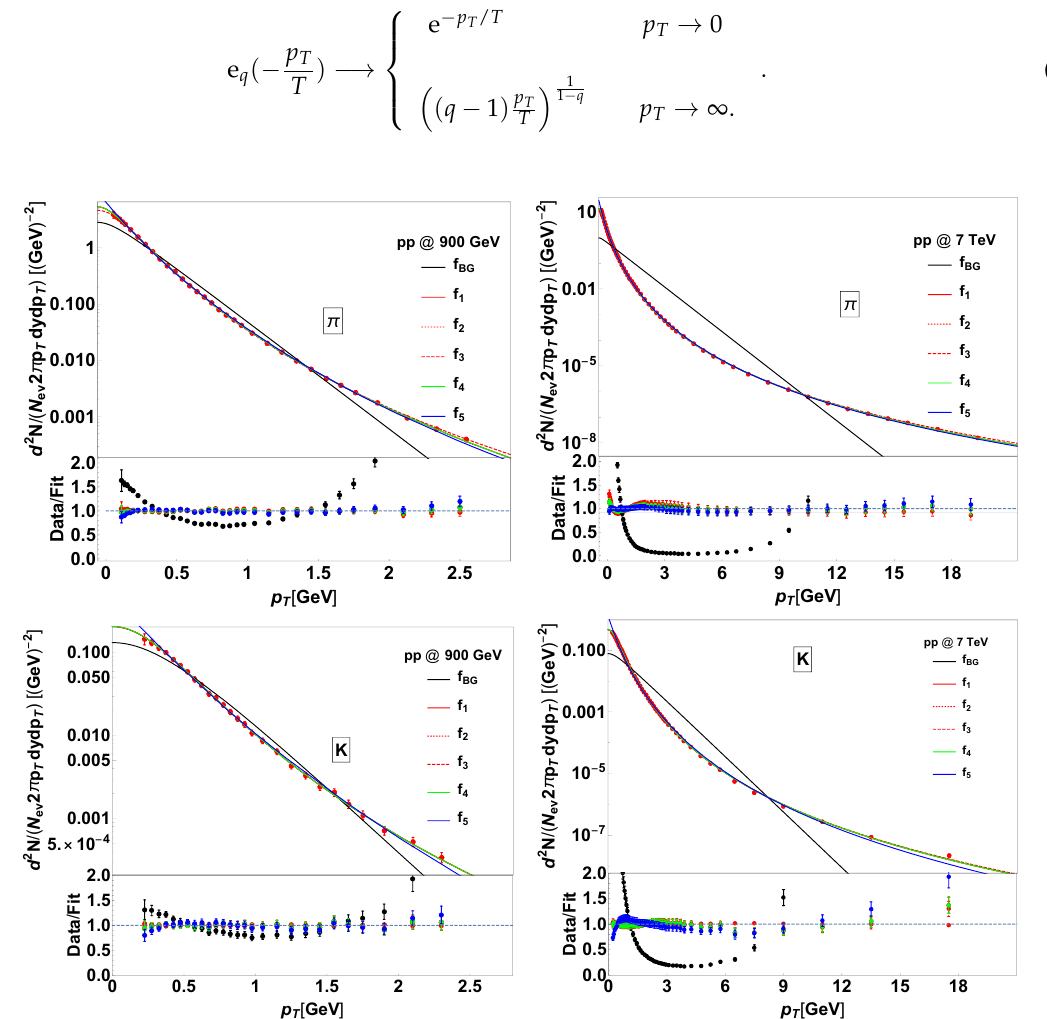
√ s = 900 GeV and √ s = 900 GeV and 0.1 < p T < 20 GeV at 7 TeV,